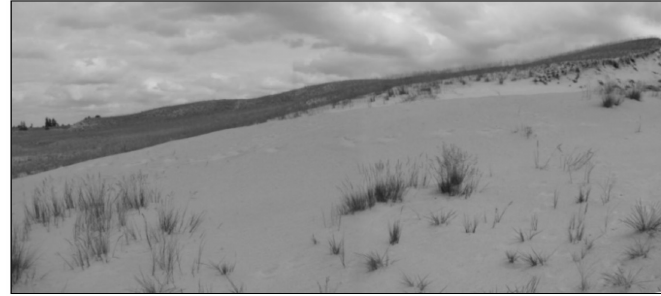
Figure 5. White (open) mobile dunes of the Curonian Spit (photo by Arvydas Urbis).